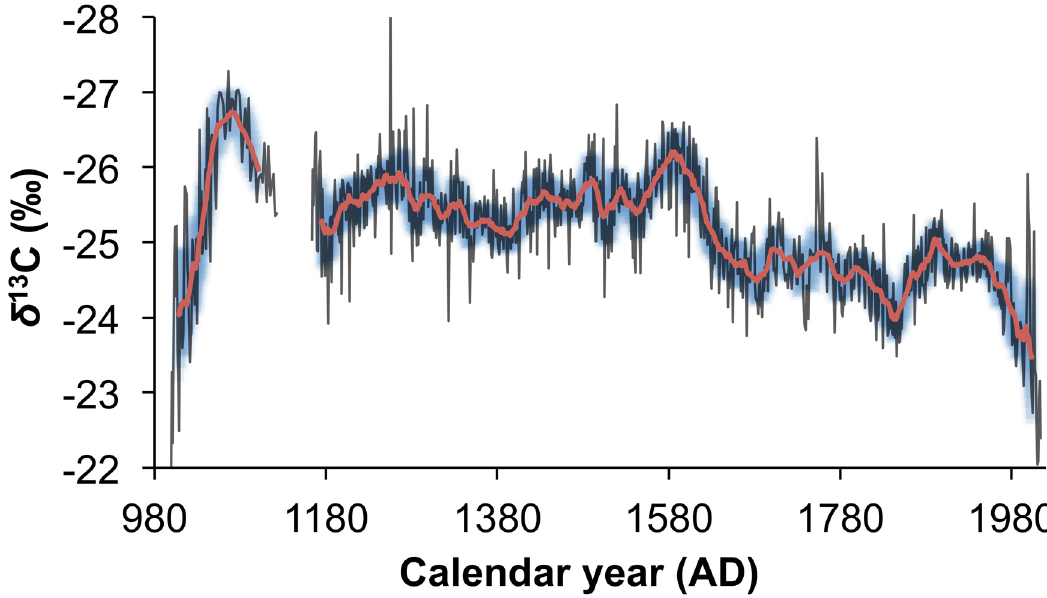
Fig 7. A regional 1000-year rainfall proxy record for the summer rainfall region of South Africa. The isotope proxy record from 4 baobabs in the Pafuri area are combined with that from 5 baobabs from the Mapungubwe area to provide a regional rainfall proxy record for the last 1000 years (black). The 21-year biweight mean (red) and biweight mean variance (blue shading) provide the climate trajectory of the